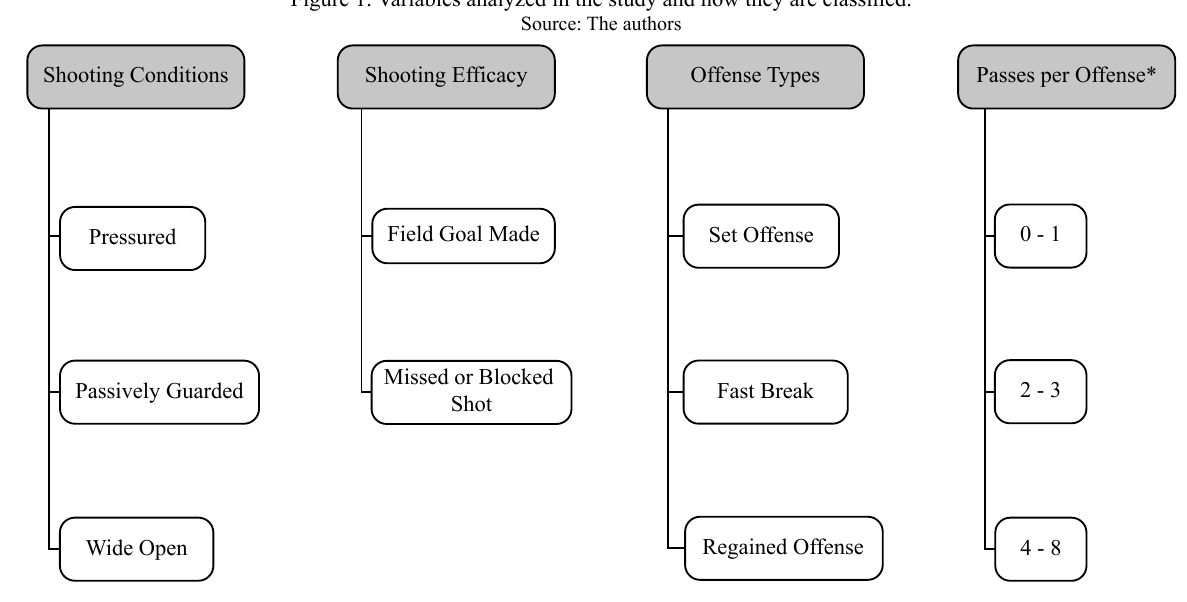
Figure 1. Variables analyzed in the study and how they are classified. Source: The authors